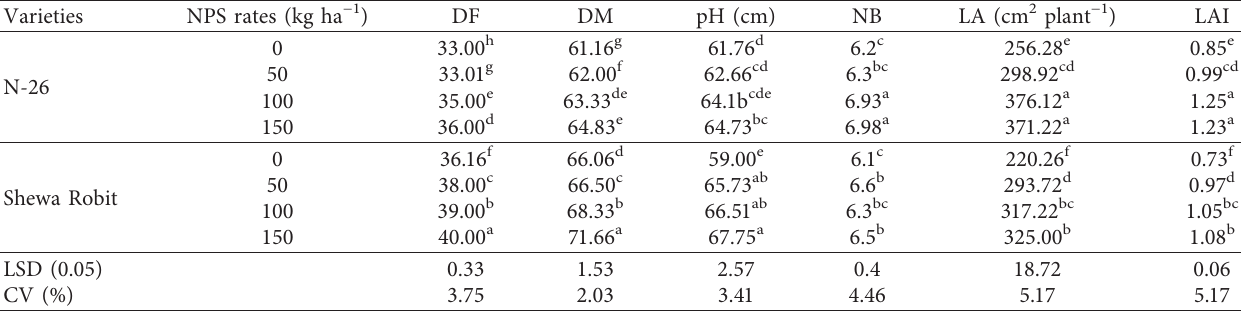
Table 2: Interaction effects of NPS fertilizer rates with varieties on days to 50% flowering (DF), days to 90% physiological maturity (DM), plant height (PH), number of branches (NB), leaf area (LA), and leaf area indices (LAI).